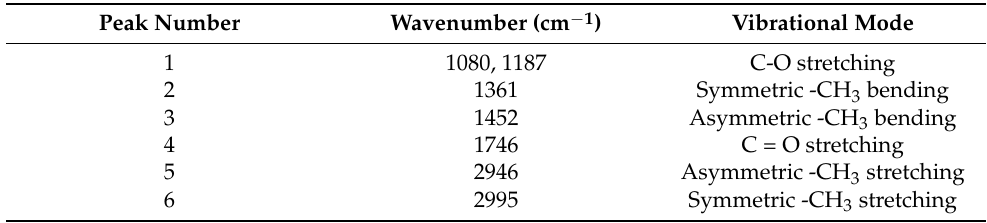
Table 2. FTIR peaks associated with the spectra of PLA in Figure 3.